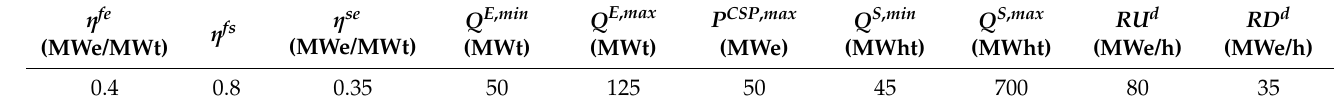
Table 2. Parameters of the CAES unit. Table 3. Parameters of the concentrating solar power (CSP) unit. Table 3. Parameters of the concentrating solar power (CSP) unit.